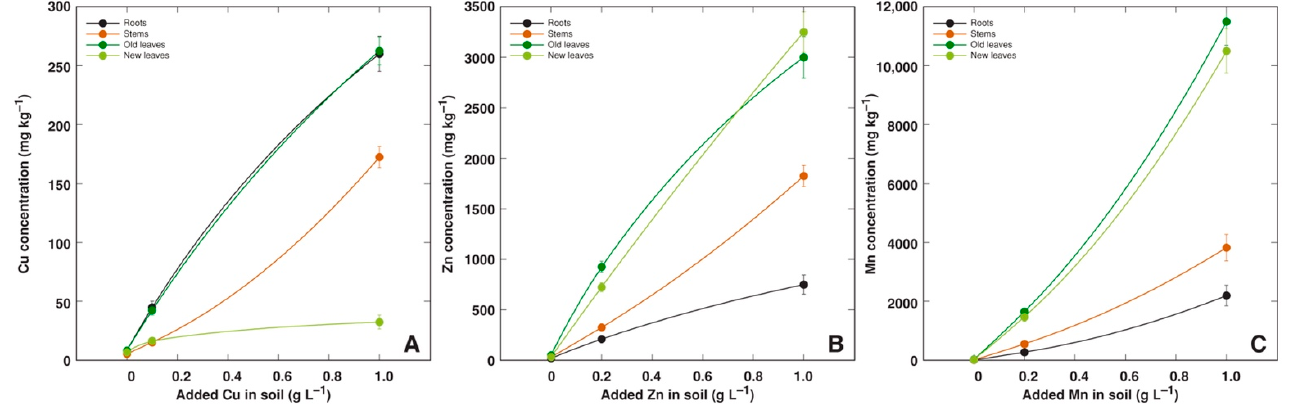
Figure 4. Effects of treatment with Cu on Cu concentration ( A ), treatment with Zn on Zn concentra- tion ( B ), and treatment with Mn on Mn concentration ( C ) in different parts of H. maximum plants (Experiment 1). Data are means ± SE from 3 replicates for each point.